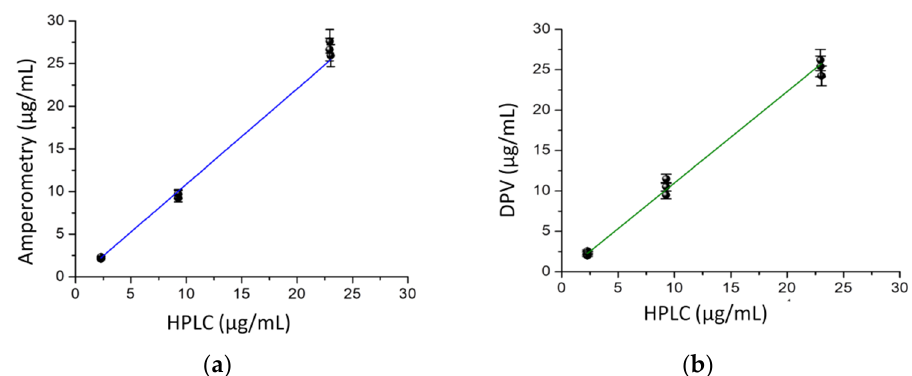
Figure 6. ( a ) Correlation between the determined concentrations of GMB (solutions of different concentrations prepared using a pharmaceutical formulation) obtained by: amperometry, DPV ( b ) and the HPLC-UV control method; the concentration range for GMB: from 2.5 to 25 µ g/mL ( n = 9).